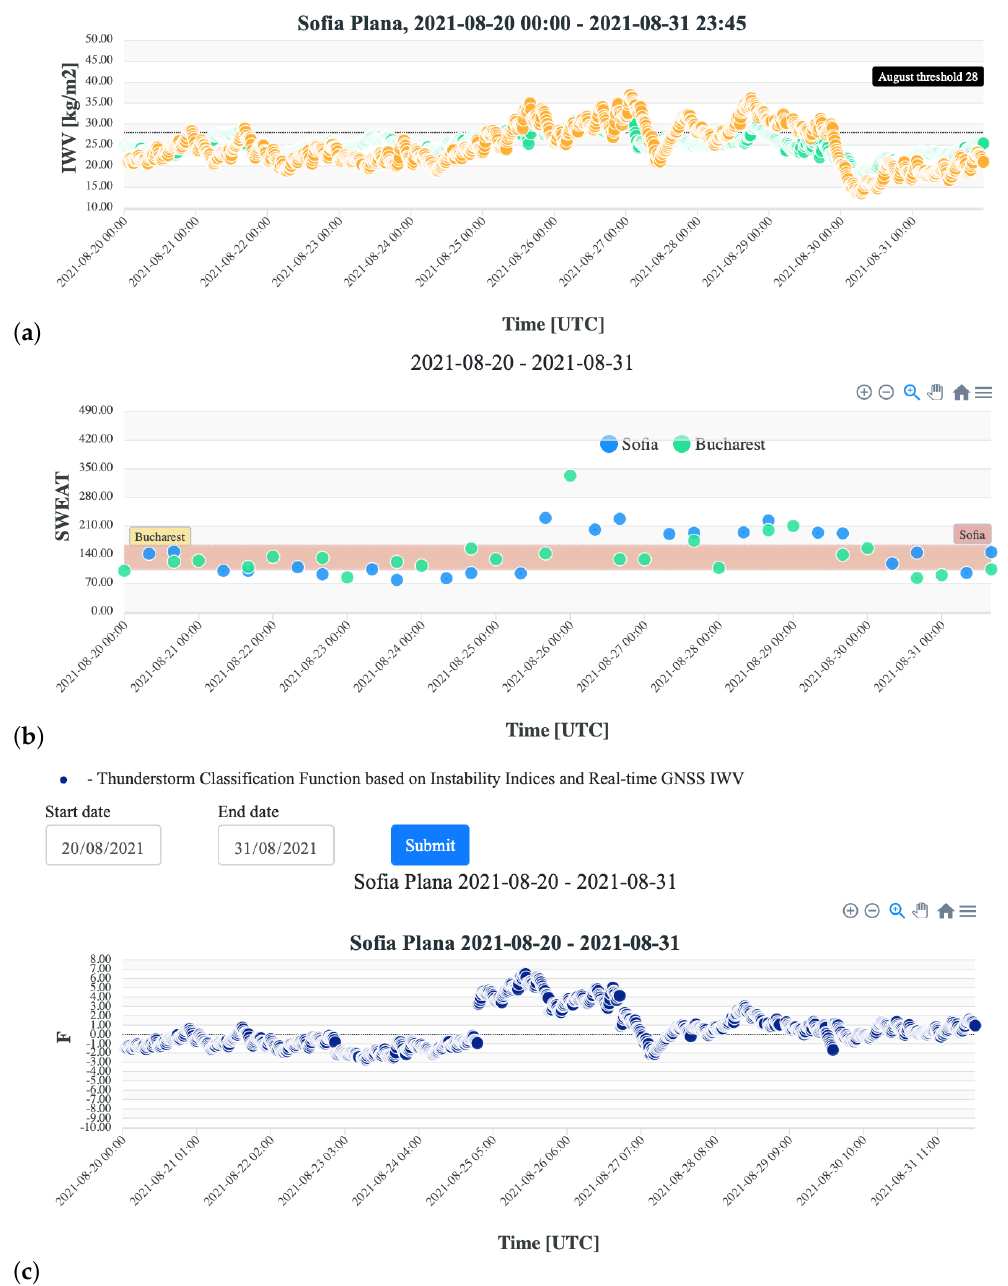
Figure 10. Storm Demo web portal sections ( a ) IWV, ( b ) SWEAT index, and ( c ) classification